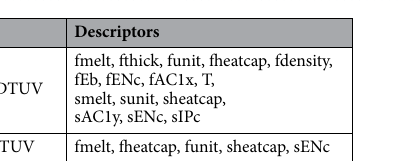
Figure 4. Venn diagram showing the amount of common descriptors picked for both decision tree and univariate testing.